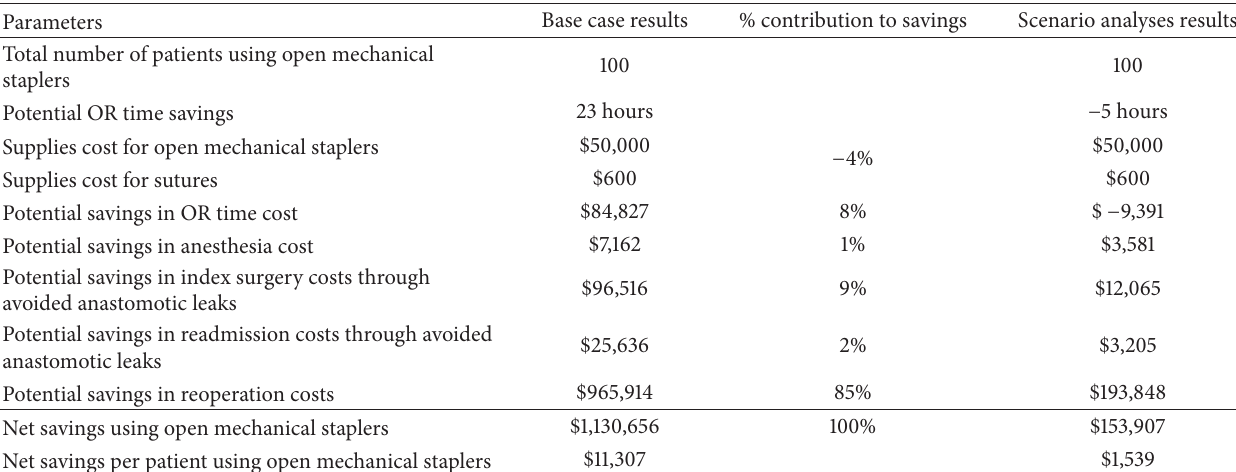
Table 6: Potential cost savings using mechanical staplers.